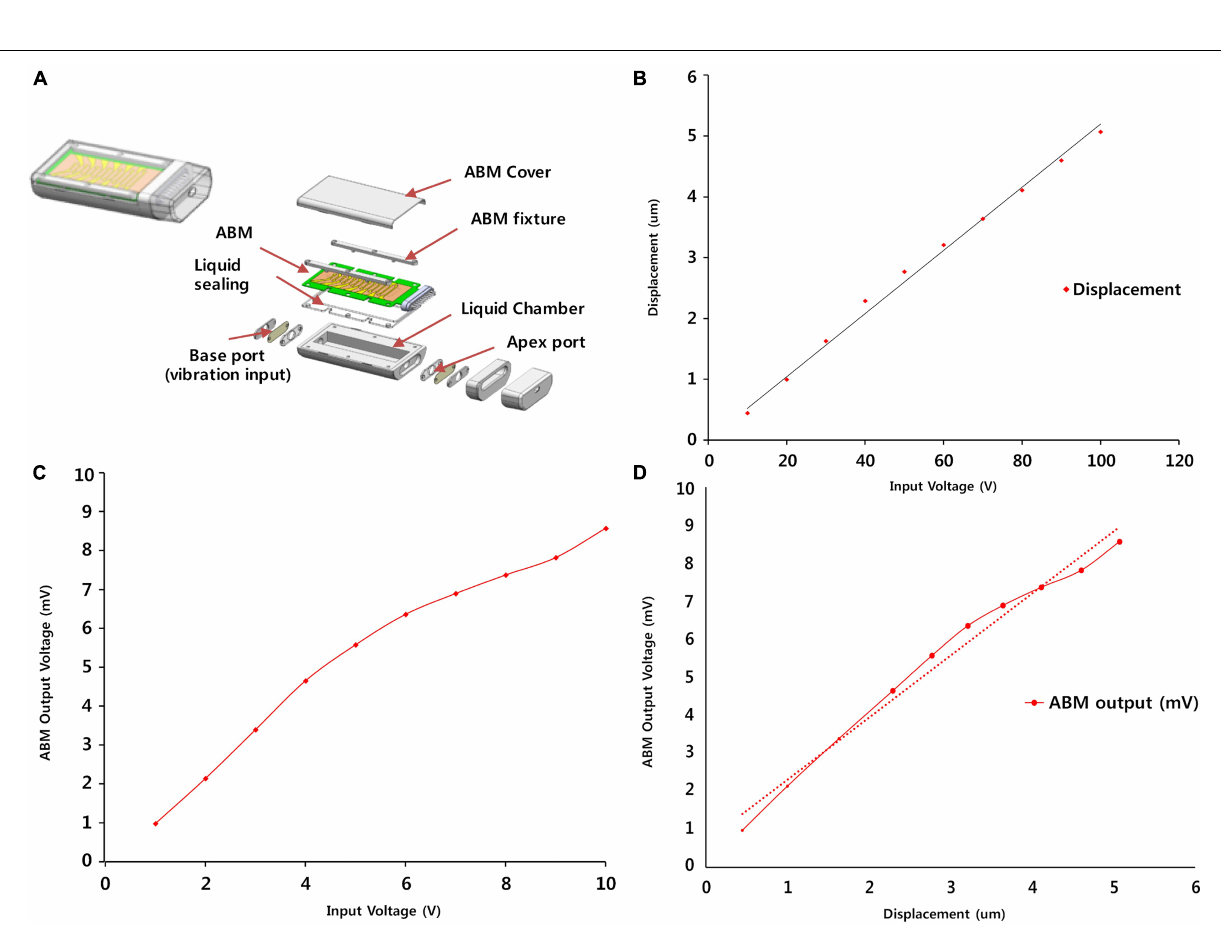
FIGURE 2 | ABM Packaging and functional evaluation of the ABM. (A) The steps involved in the fabrication and packaging of the ABM. (B) The displacement of the base port according to input voltage of piezoactuator. (C) The electrical output from ABM according to the input voltage of the piezoactuator. (D) The relationship between the displacement of the base port and the electrical output from